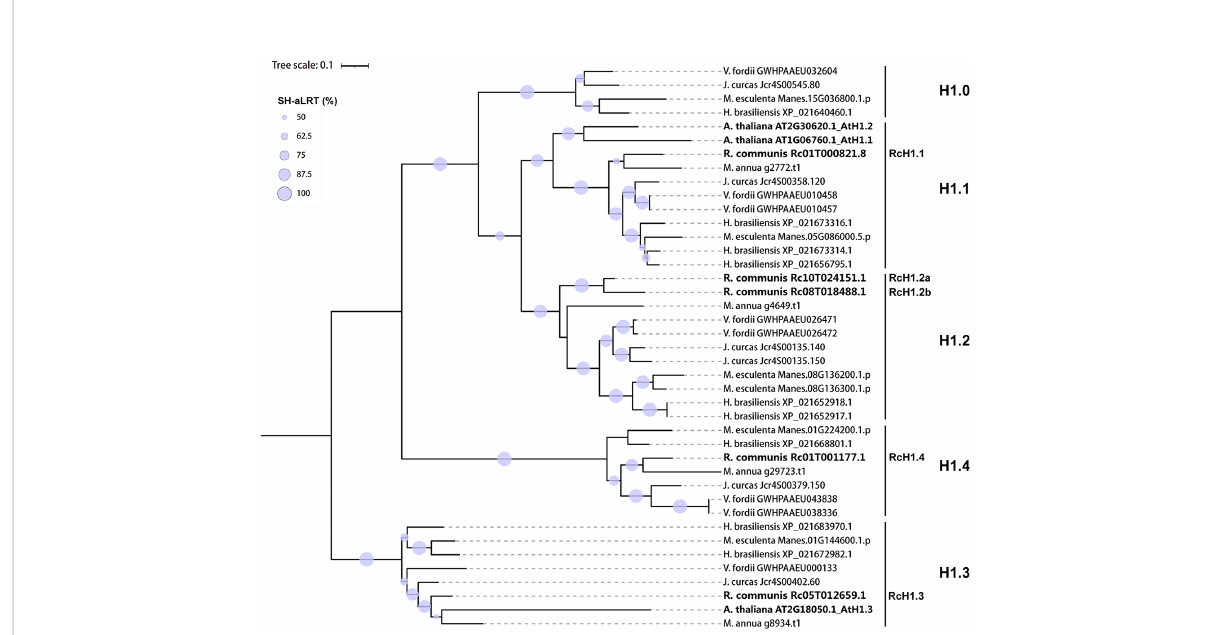
FIGURE 2 Maximum likelihood phylogenetic tree based on amino acid sequences of H1 linker histones in Ricinus communis , Hevea brasiliensis , Jatropha curcas , Manihot esculenta , Mercurialis annua , Vernicia fordii and Arabidopsis thaliana . The branches labeled by light grey circles indicate > 50% SH-like supports of approximate likelihood ratio test (SH-aLRT) and over 50% ultrafast bootstrap